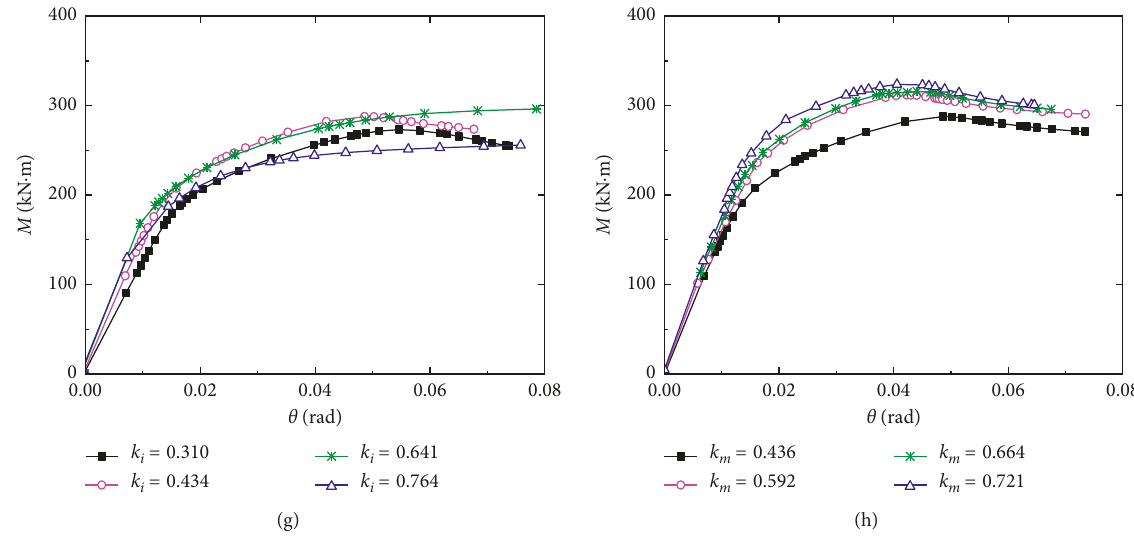
Figure 15: Effect of various parameters on the M - θ relationship of the CFDST column-beam joint. (a) Stiffened height ( h axial load level ( n ). (c) Strength of beam steel ( f y1 ). (d) Strength of tube steel ( f y2 ). (e) Concrete strength ( f cu ). (f) Steel ratio ( α ). (g) Beam-to- column linear stiffness ratio ( k i ). (h) Beam-to-column bending capacity ratio ( k m